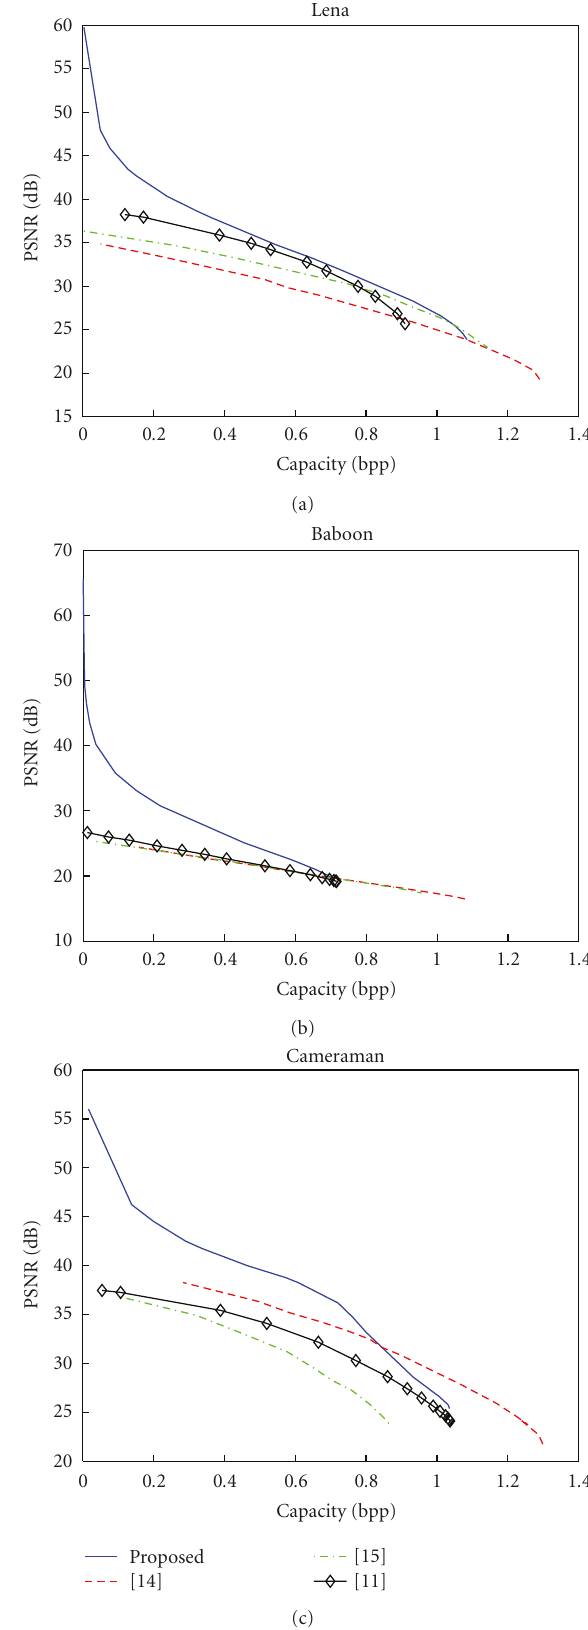
Figure 4: Performance comparison on test images Lena, Baboon, and